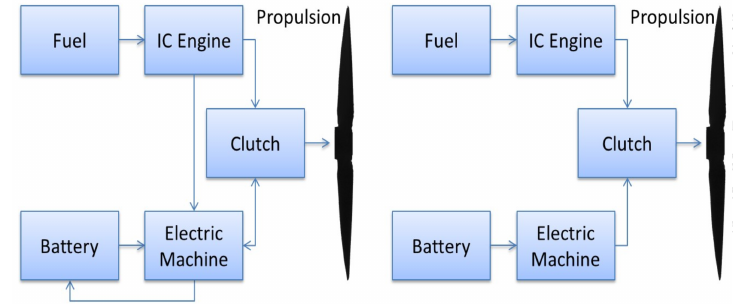
Figure 6. Parallel configuration energy flow chart, with ( left ) and without ( right ) the ability of the IC engine to drive the electric machine and hence recharge the battery.